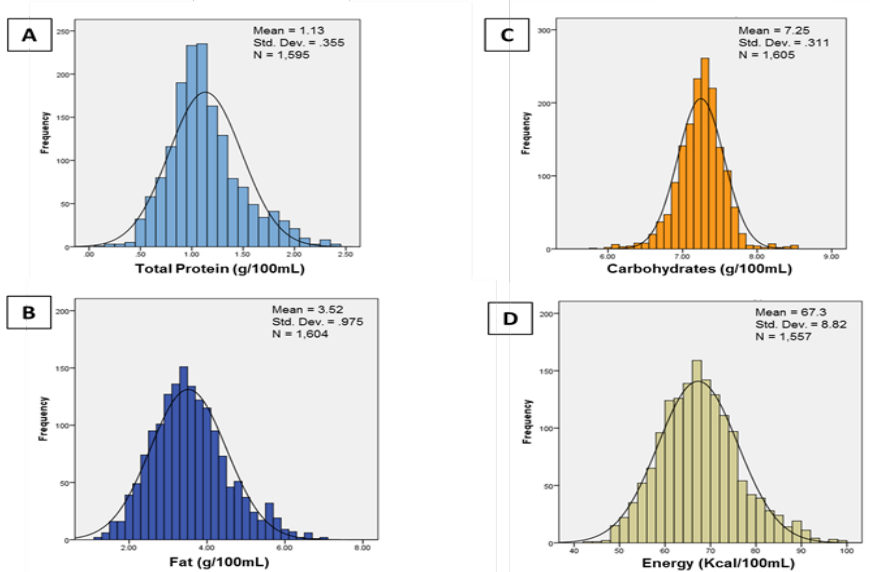
Figure 1. Distributions of protein (panel A ), fat (panel B ), carbohydrate (panel C ), and energy (panel D ) content in 1626 human milk samples from 37 very preterm infants. Mean (SD) protein content was 1.13 (0.36) g / dL, fat 3.52 (0.98) g / dL, carbohydrate 7.25 (0.31) g / dL, and energy 67.3 (8.8 kcal / dL) or 20.2 (2.6) kcal / oz. Interquartile ranges were: protein 0.90, 1.30 g / dL; fat 2.90, 4.10 g / dL; carbohydrate 7.10, 7.40 g / dL; and energy 61.0, 72.0 kcal / dL. Nutrient content was measured with a mid-infrared